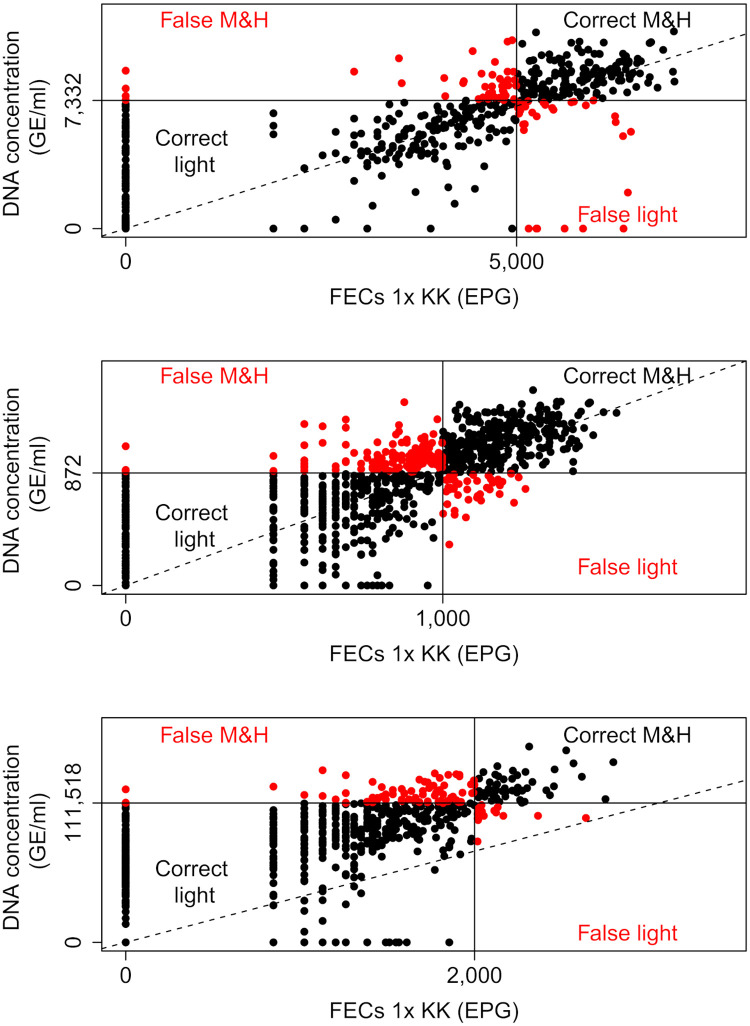
Agreement in classifying infection intensities between Kato-Katz and qPCR.The scatter plots represent the de degree agreement between qPCR and a single Kato-Katz (1x KK; reference method) in classifying infection intensity cases based World Health Organization (WHO; Table 1) and method-specific thresholds (Table 4) for Ascaris, Trichuris and hookworms. The full black dots indicate that intensity of infection was correctly classified as light (bottom left quadrant) and moderate-to-heavy (M&H; top right quadrant). The red dots indicate that intensity of infection was falsely classified as light (bottom right quadrant) and M&H (top left quadrant). The full lines represent the thresholds, the dashed line represents the line of equality.